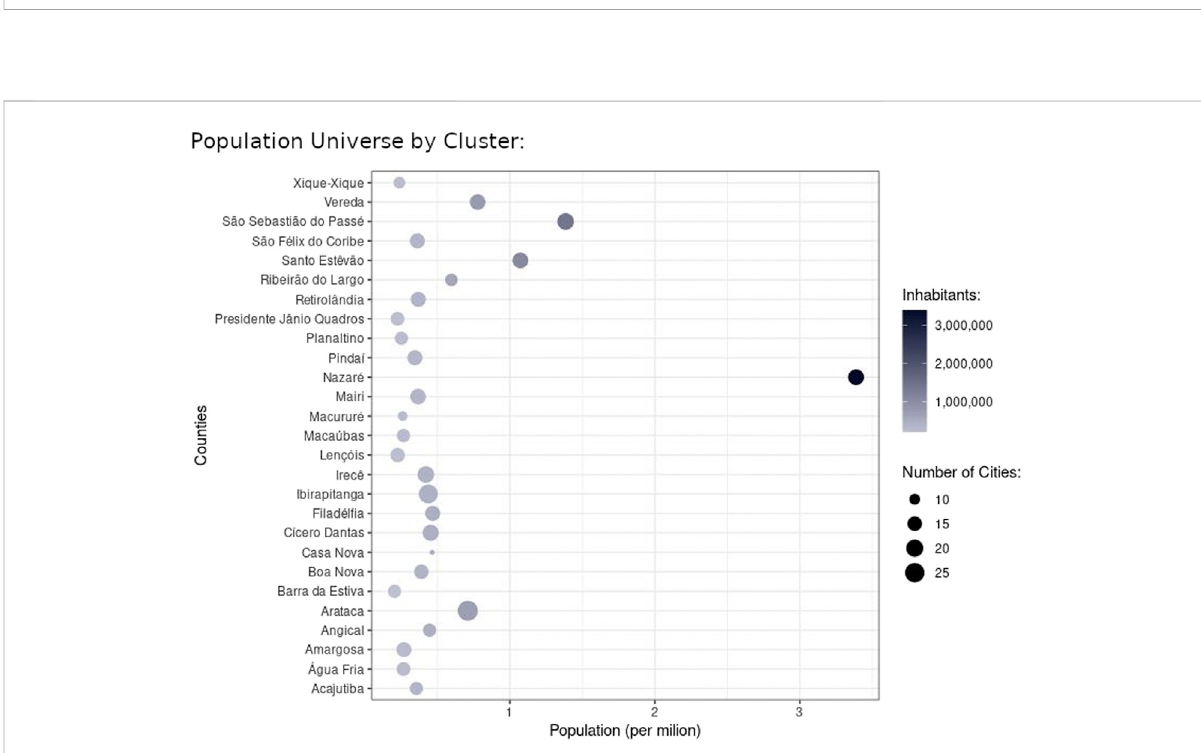
FIGURE 6 Graph of the relationship between the type of generation and the groupings, highlighting the development of multiple consumer units (CU).